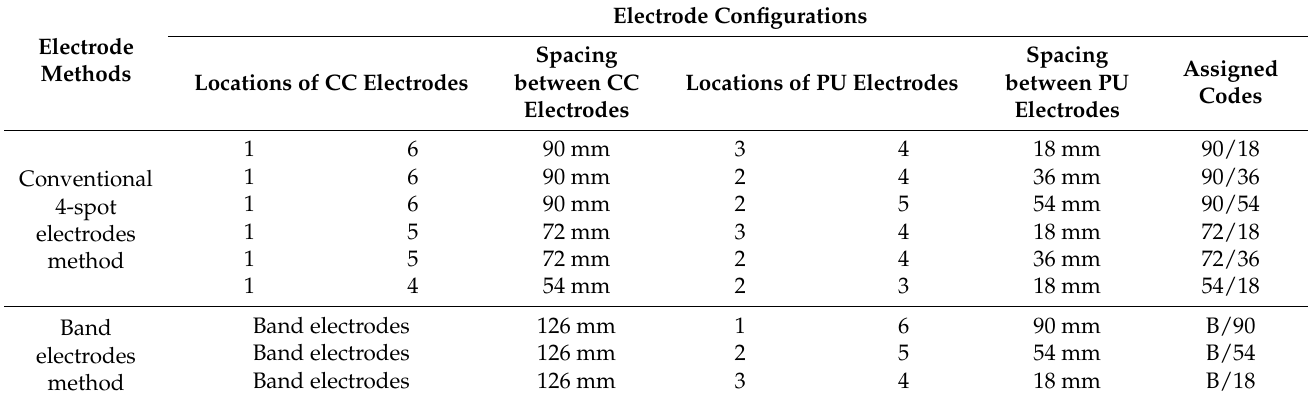
Table 3. Assigned codes for various electrode configurations in phantom pumping experiments.